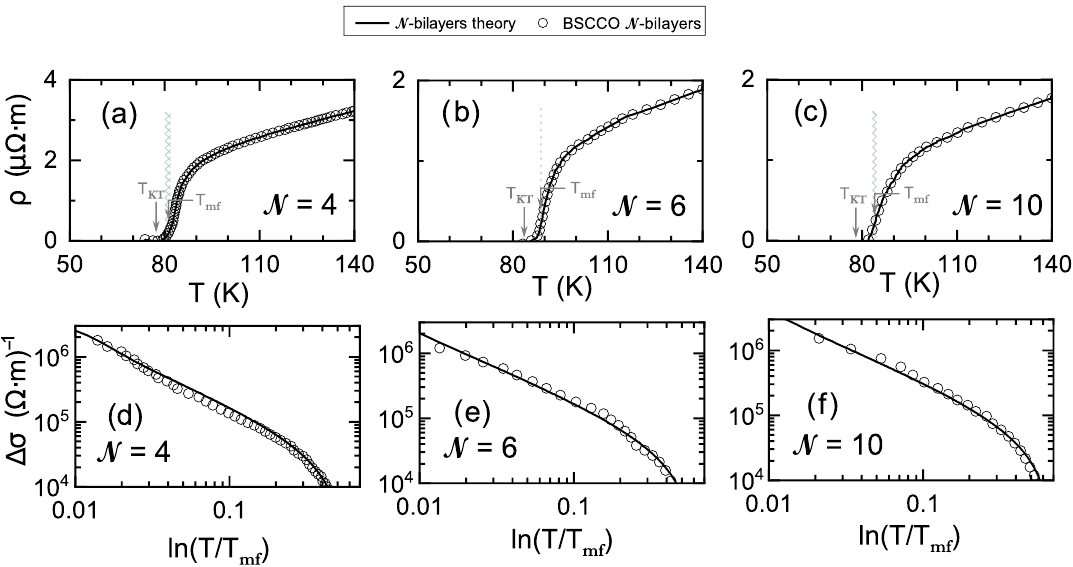
Figure A1. Resistivity ρ versus temperature T (open circles, panels ( a – c )) and paraconductivity ∆ σ versus ε = ln ( T / T mf ) (open circles, panels ( d – f )) obtained experimentally by Zhao et al. [40] in ultra-thin films of Bi 2 Sr 2 CaCu 2 O 8 + x , for three representative number of CuO 2 bilayers N . The solid lines are fits to these data using our equations. We used as parameters, for N = 4, 6, 10, respectively, the following: T mf = 81.2, 88.8, 83.9 K; T KT = 77.3, 83.5, 78.0 K; δ T mf = 0.7, 0.25, 0.65 K; b 0 = 4, 6, 5; ε c = 0.55, 0.6, 0.68; Gi = 0.009, 0.005, 0.004. The normal-state background ρ n was obtained by linear extrapolation of the data above 160 K (we observe no significant changes when varying this temperature). The shadowed bands correspond to the temperature regions from T mf − δ T mf up to T mf + δ T mf